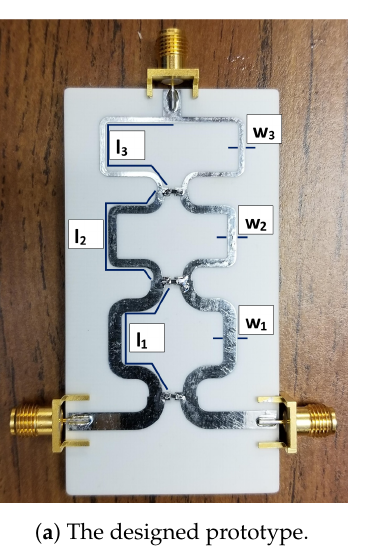
Figure 5. The designed prototype using the proposed analytical design methodology and its measurement using a Tektronix TT506A VNA. The VNA display on the computer screen shows the measured isolation. Dimension (mm): l 3 = 35, w 3 = 1, l 2 = 31.3, w 2 = 1.65, l 1 = 31.83, w 1 = 2.54. Resistors ( Ω ) optimized to the closest commercially available values: 2 R 3 = 499,2 R 2 = 232,2 R 1 =